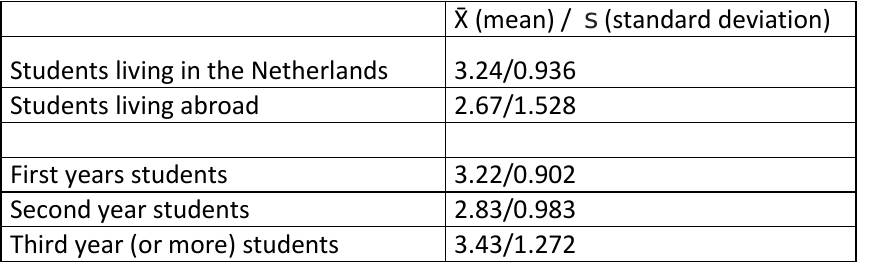
Table 3 "I feel connected with my fellow students"; N=40